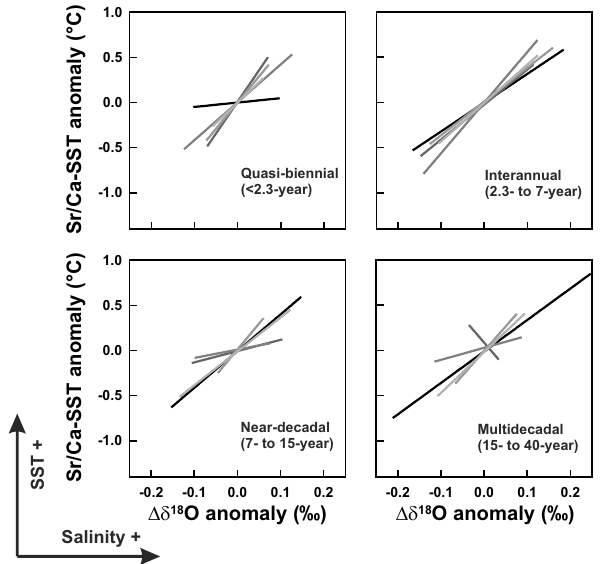
Fig. 9. Linear regressions between Gaussian bandpass-filtered coral 1δ 18 O and Sr/Ca-SST time series for Bonaire coral records with length > 20yr as calculated after Corr`ege (2006) and Gagan et al. (1998). Note that for all investigated timescales, most coral records indicate positive correlation coefficients which suggest that periods of warmer than average sea surface temperatures (SST) are characterised by more saline conditions and vice